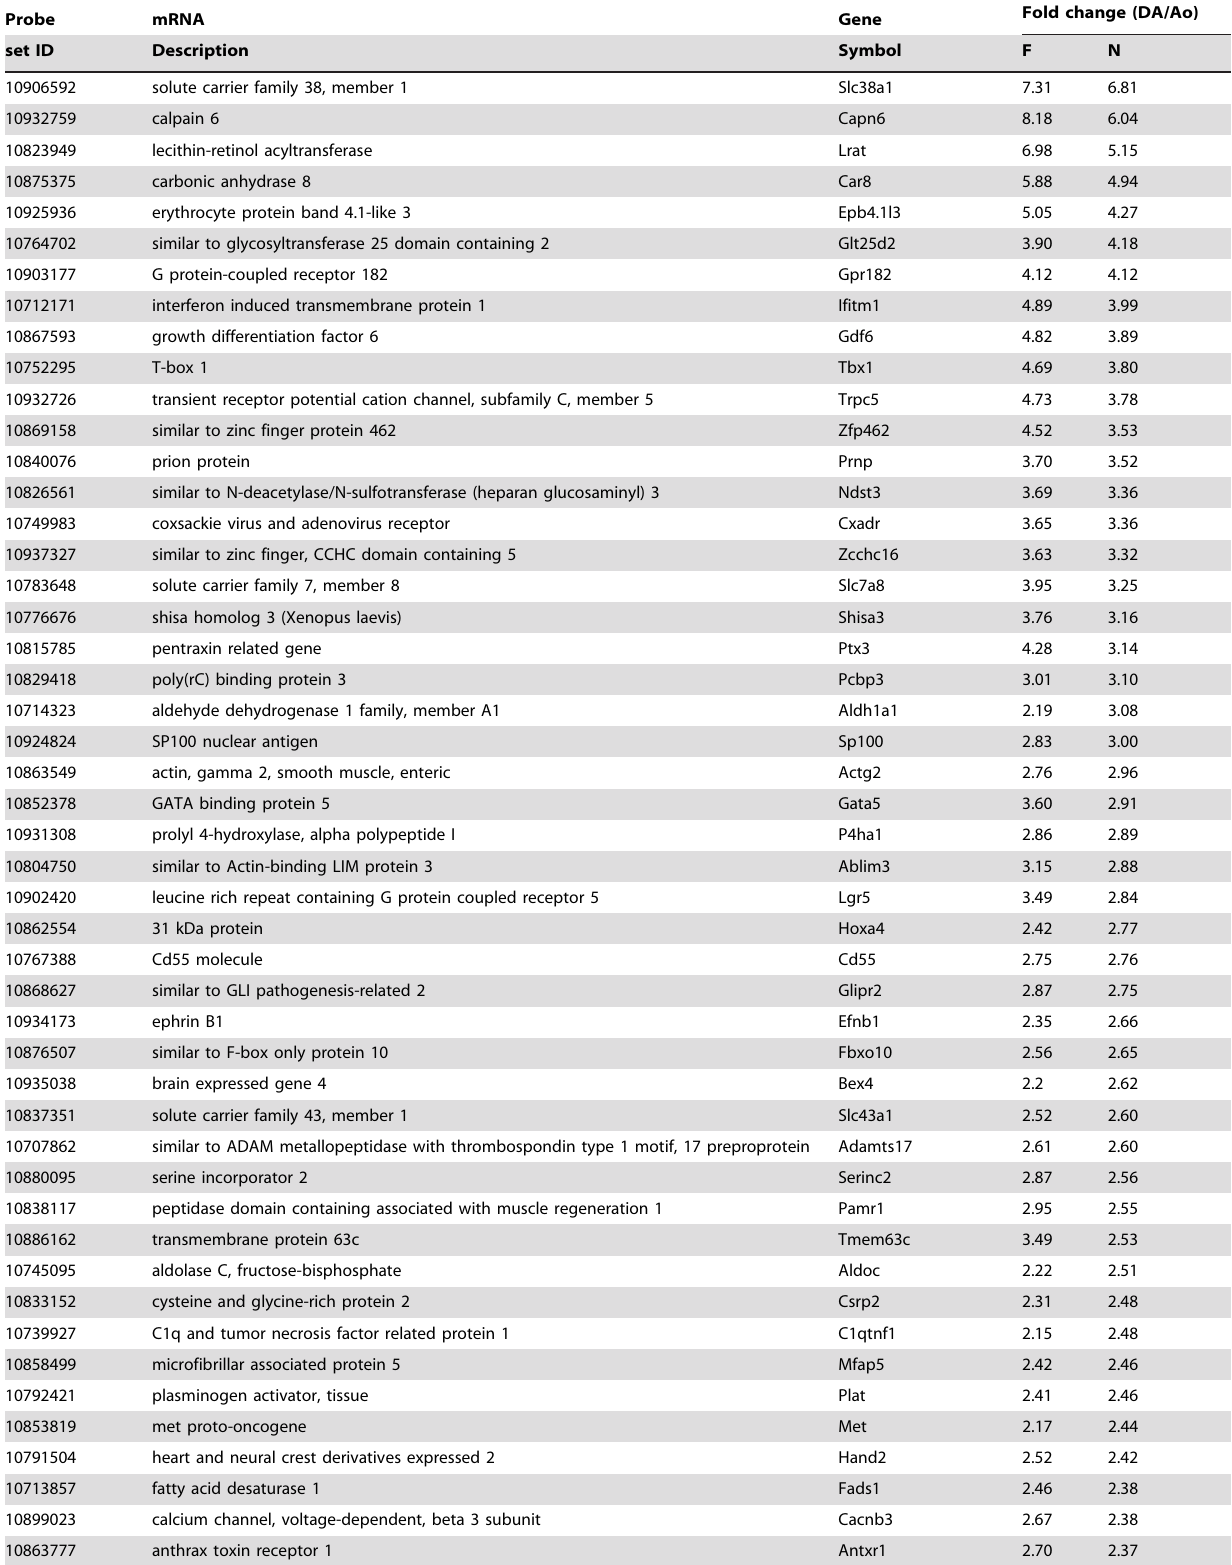
Table 2. DA endothelium-dominant